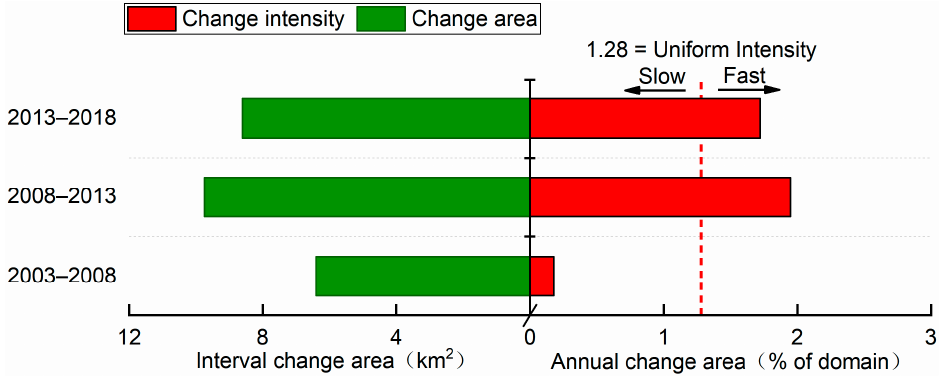
Figure 3. Analysis of interval level for three-time intervals: 2003–2008, 2008–2013, and 2013–2018.